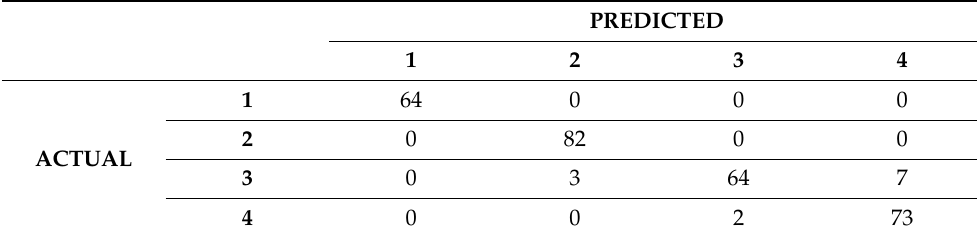
Table 3. Confusion matrix for fixed hyperparameter